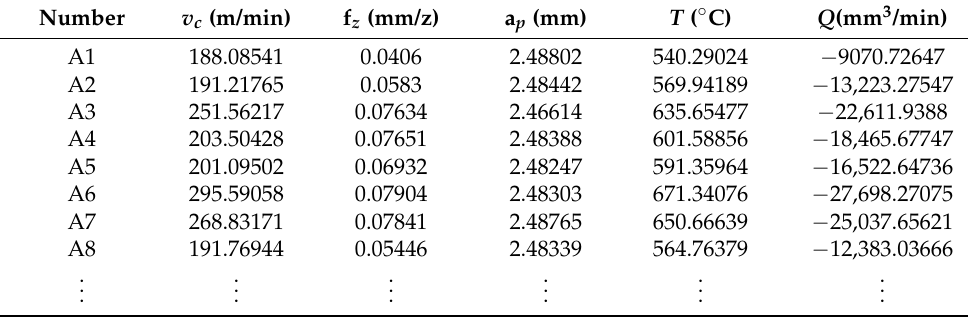
Figure 11. Pareto optimal frontier. Table 6. Pareto optimization solution